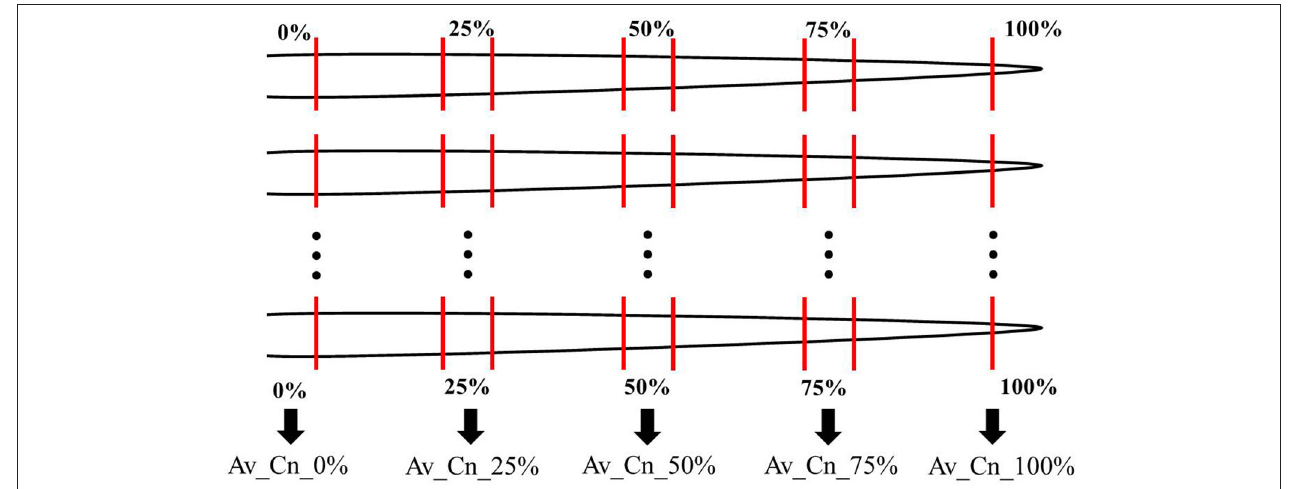
FIGURE 1 | Root sampling scheme for all experiments. From every root, five root segments of 1cm length were taken at the root basis (0%), the root tip (100%), the middle of the root (50%) and further two in between (25 and 75%). The FTIR-ATR spectra of the corresponding root position of one cultivar or provenience was used to calculate an arithmetic average (Av) which are labeled “Av_Cn_0%” in the figures. In the text, the abbreviation “Av-spectra” is used. Cn means cultivar number. See Table 2 for the number of roots used for the averages.